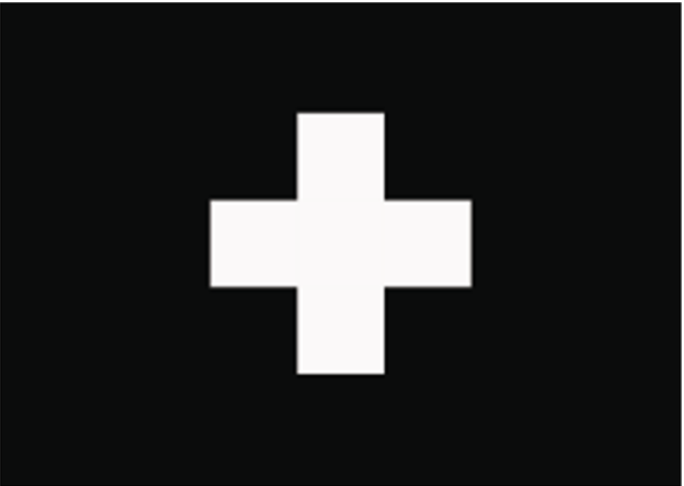
Figure 3. Ernest Edmonds, still from Fragment (1964–65).